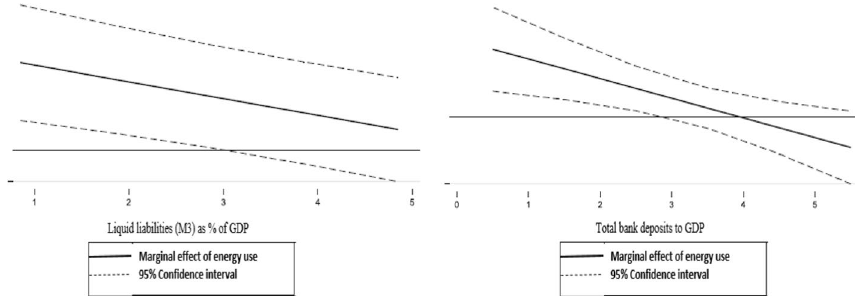
Fig. 10 Effects of energy consumption on CO 2 emissions as financial development changes. Dependent variable: CO